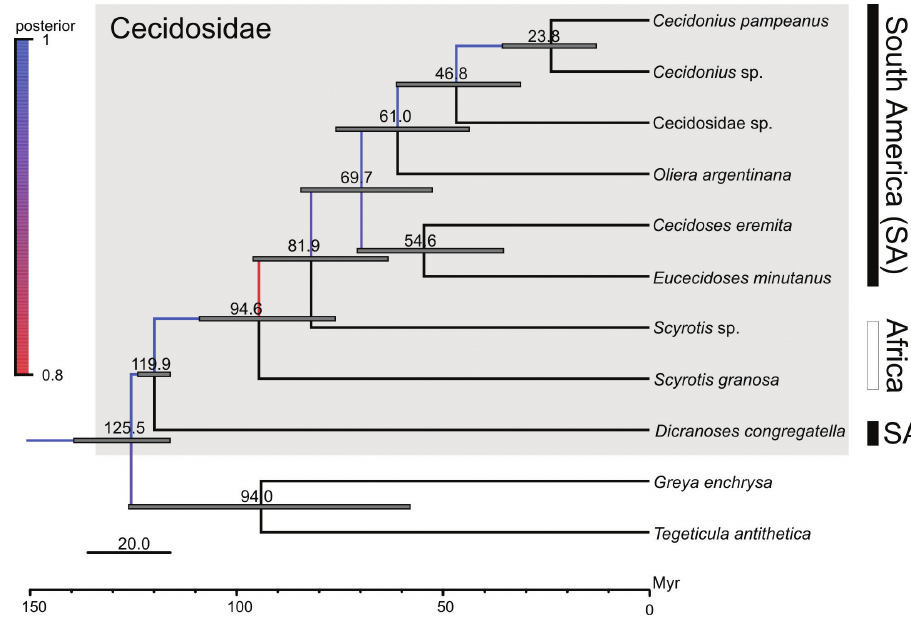
Figure 1. Molecular phylogeny of Cecidosidae. Bayesian time-calibrated consensus tree based on cy- tochrome oxidase subunit I (COI), r16S ribosomal (16S) and Wingless (Wg) genes. Prodoxidae ( Greya enchrysa and Tegeticula antithetica ) was used to root the tree. Colored branches indicate posterior prob- ability support for the equivalent node following the legend. Dark gray bar indicates confidence interval for each node age estimate, presented in millions of years ago (Mya).